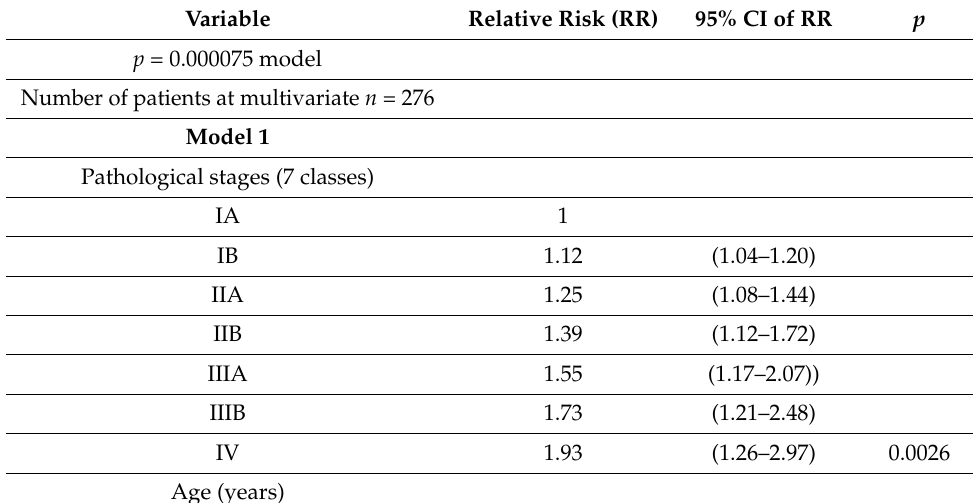
Table 3. Multivariate analysis of factors influencing risk of death at 20 years by Cox proportional hazards models. In this main model, model 1, the pathological stage in 7 classes, and model 2 correspond to model 1 adjust to preoperative